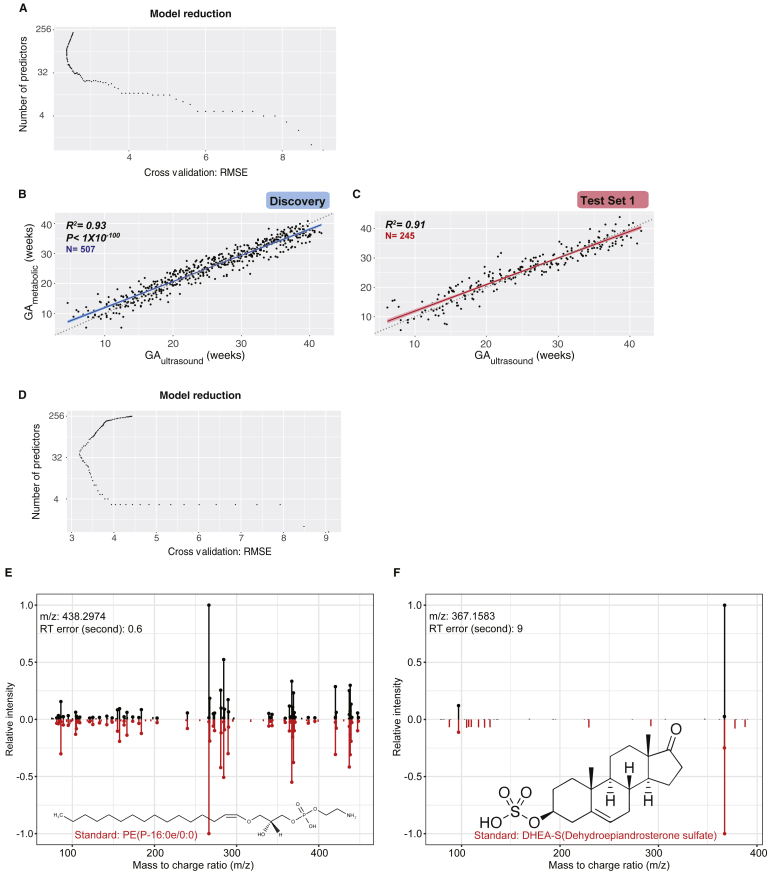
Metabolites Predict Gestational Age in Machine-Learning Models, Related to Figure 4(A) Feature selection for predicting gestational age (GA) using metabolomic features.(B and C) GA predicted by metabolic features (GAmetabolic, y axis) highly correlates with clinical values determined by standard of care (by first-trimester ultrasound, GAultrasound, x axis) in the Discovery (B) and the validation cohort (Test Set 1) (C). The 95% confidence interval for the linear regression is represented by the gray area.(D) Feature selection for predicting GA using identified metabolites.(E and F) Measured MS/MS fragmentation profiles (upper) matching of PE(P-16:0e/0:0) (E) and DHEA-S (F) with the MS/MS of standard compounds (lower). GA, gestational age.